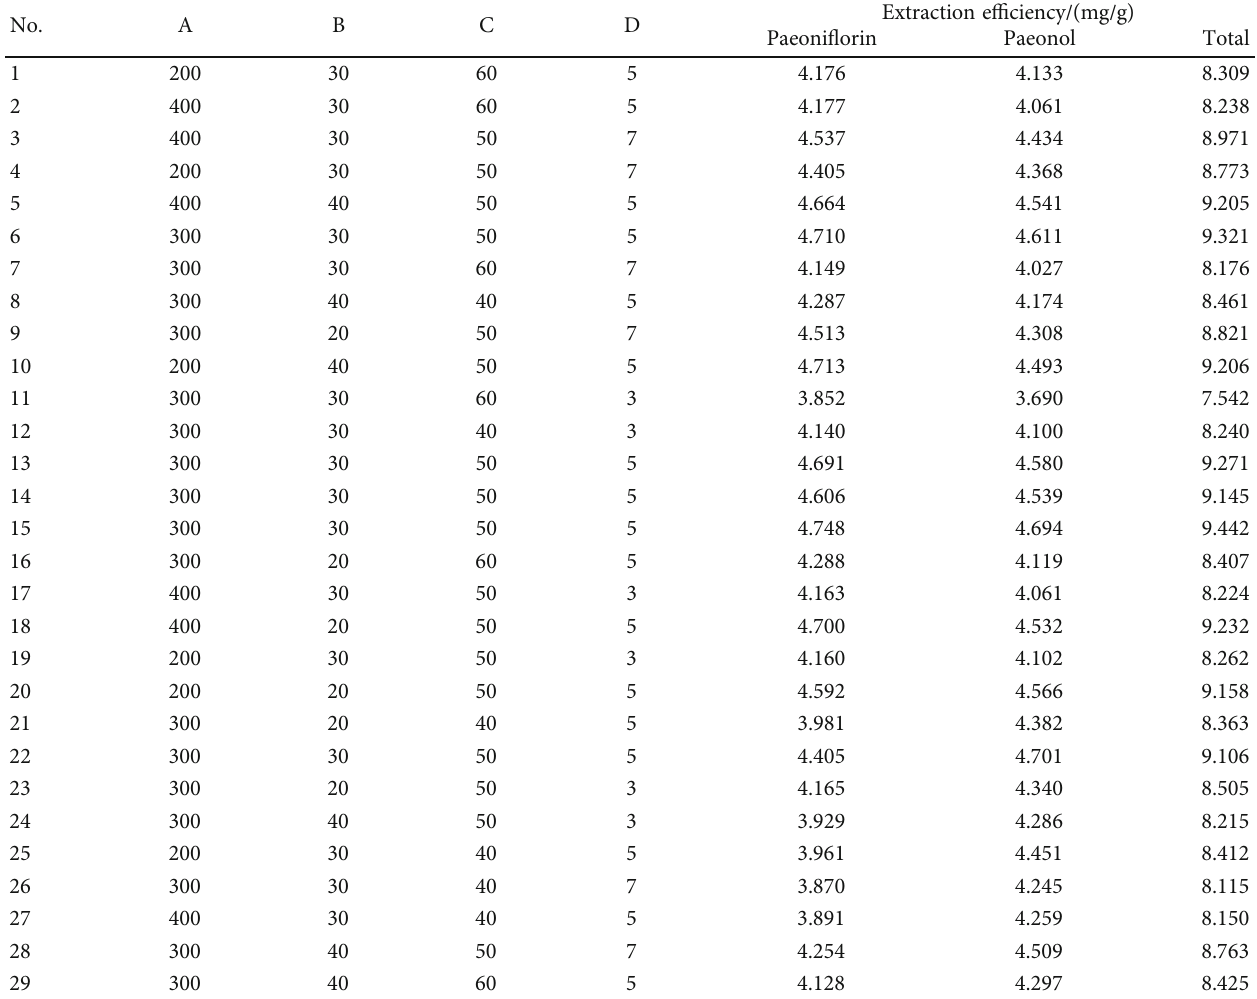
Table 5: Box-Behnken response surface design and